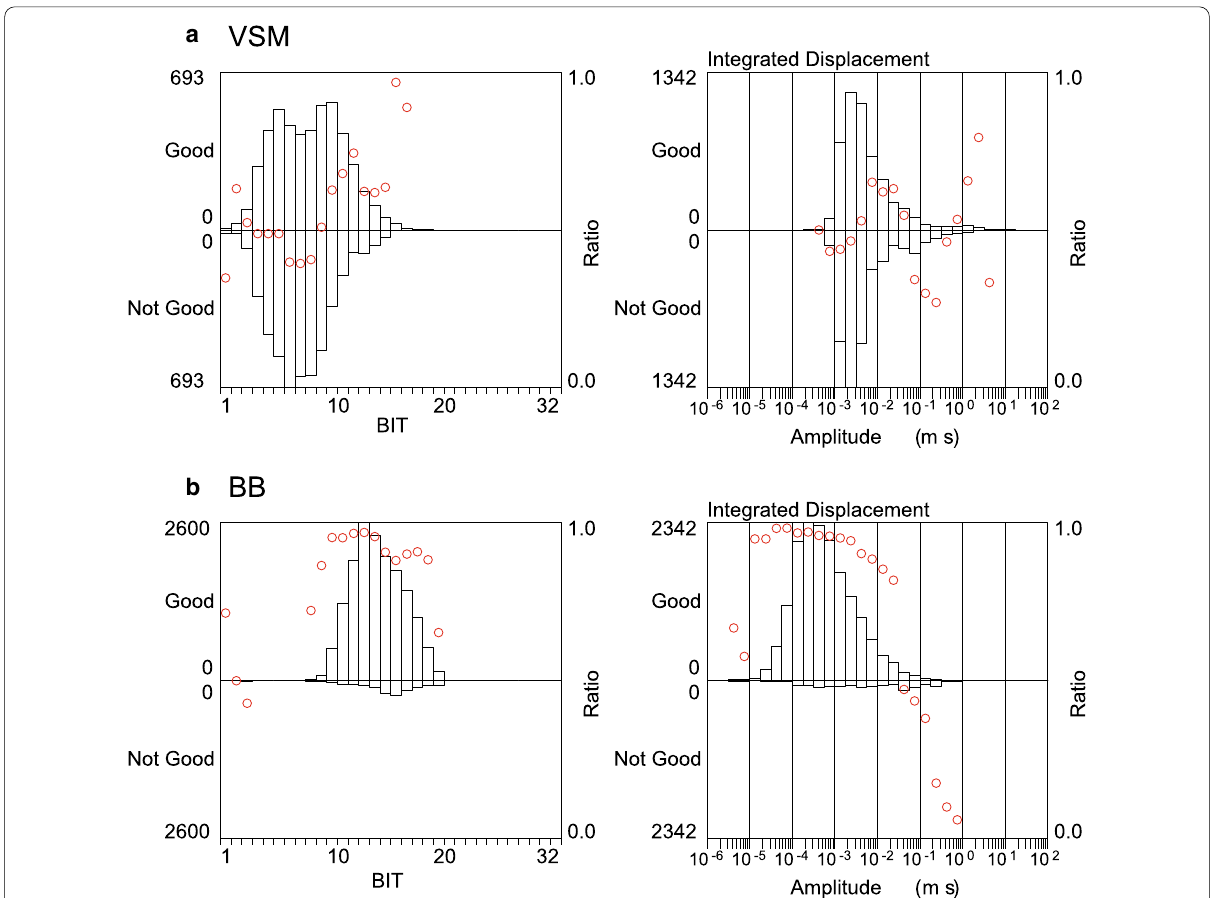
Fig. 4 Distinguishing “Good” and “Not Good” data. Good data are data with peak integrated displacement times between T 0 + T S and T 0 + 2.5 T S + T D , as shown in Fig. 3. The peak digital counts of the original record (BIT, left) and the integrated displacement amplitudes (right) are compared between a velocity-type strong-motion (VSM) seismometers and b broadband (BB) seismometers. Good data are shown above the 0 line, and Not Good data (as defined in the text) are shown below the line. Ratios of Good good to the total number of data are shown by red circles (right-side